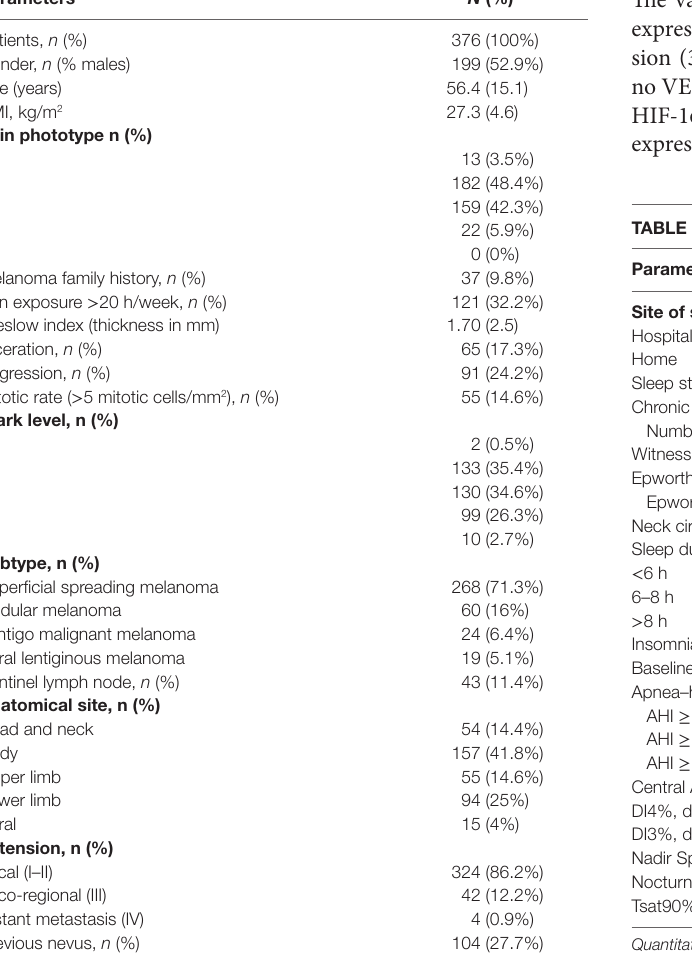
TaBle 1 | Patient and cutaneous melanoma characteristics ( n = 376).